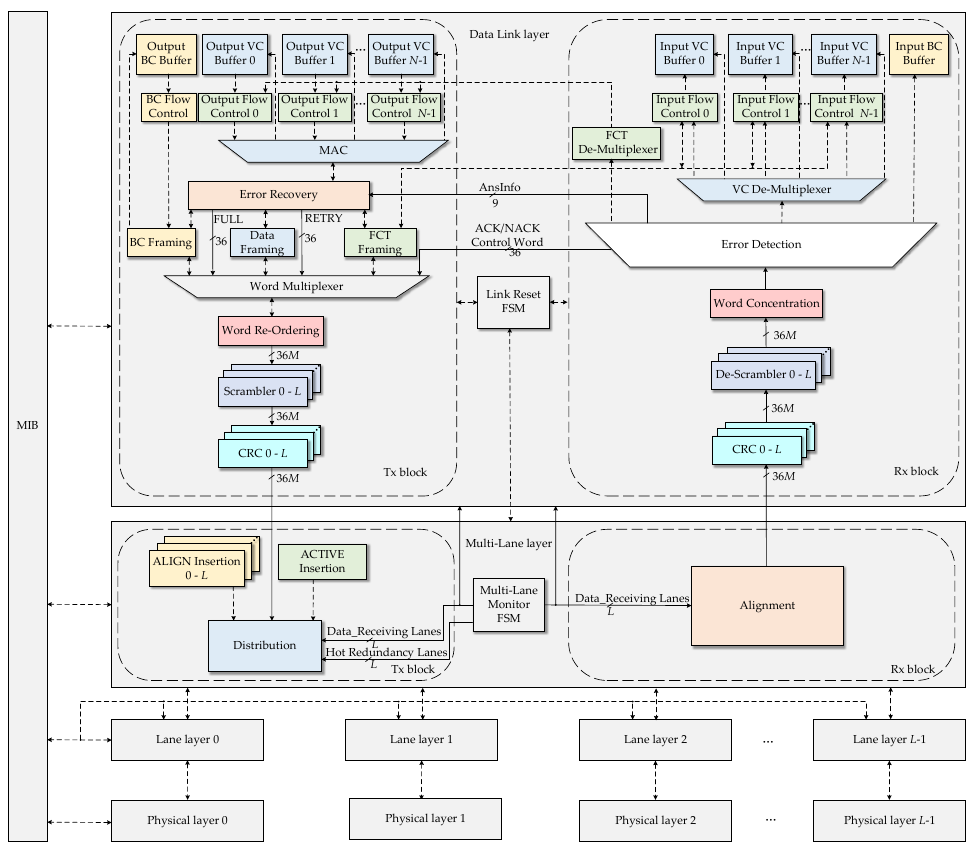
Figure 2. Overall architecture of the E-ML-SpFi core. The broadcast subsystem is constituted by an output broadcast (BC) buffer, a BC flow control block, a BC-framing block and an input BC buffer in the Data-Link